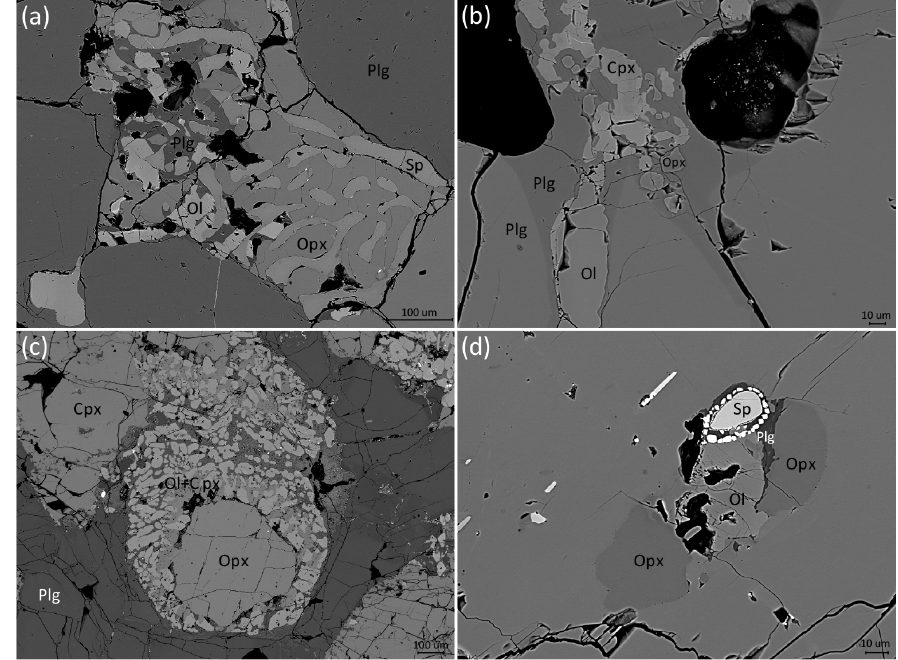
Figure 4. SEM-BSE images showing typical microstructures in the San Quintín xenoliths. (a) Symplectite with intergrown orthopyroxene, spinel, plagioclase, and olivine in SQW-75. (b) Melt patch containing plagioclase, olivine, clinopyroxene, and orthopyroxene. Compositional variation between two types of plagioclase can be seen in the lower left part of the image (SQW-114). (c) Orthopyroxene with a rim containing olivine, plagioclase, and clinopyroxene (SQW-115). (d) Inclusion in a clinopyroxene porphyroclast. The inclusion contains spinel with a magnetite rim, orthopyroxene, plagioclase, and olivine (SQW-75).